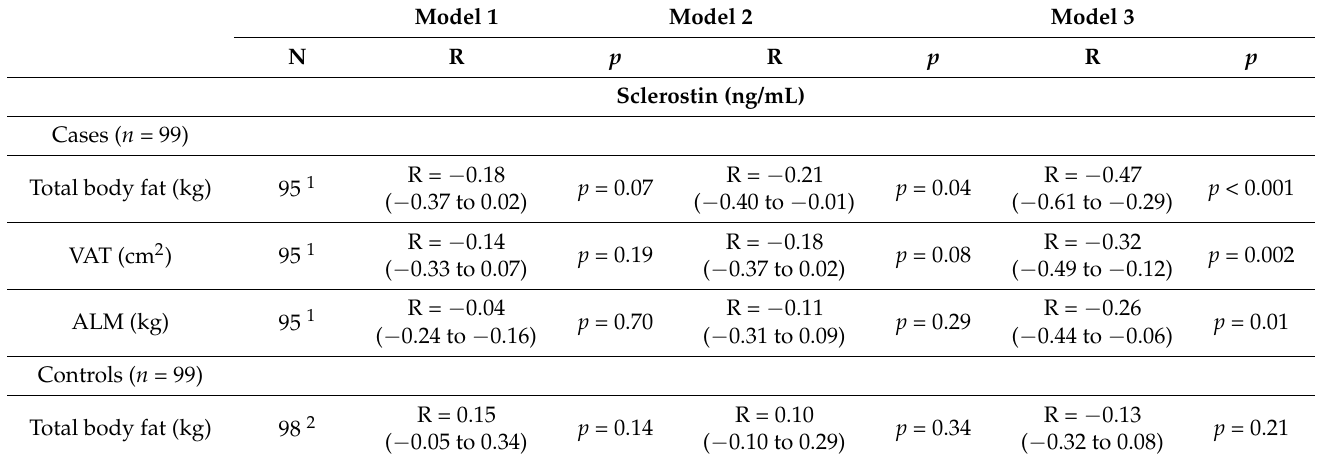
Table 4. Relationship between SOST and visceral adipose tissue, total body fat and appendicular lean